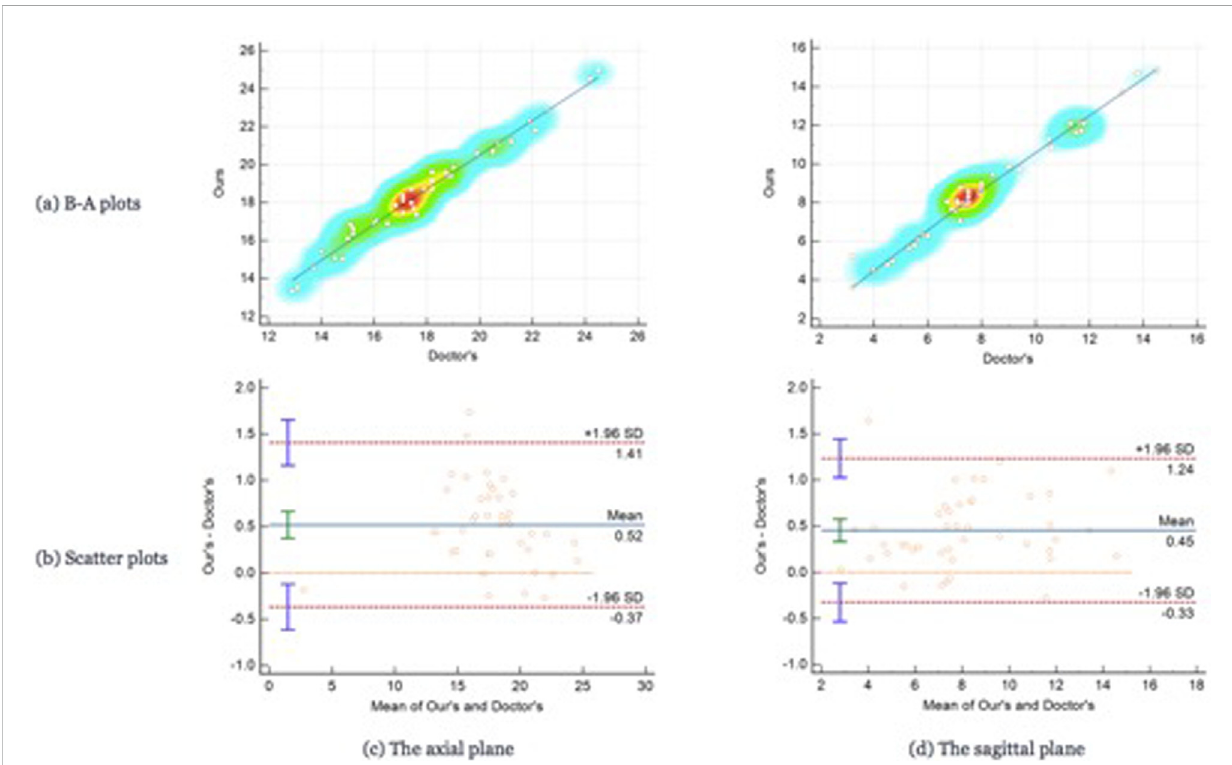
FIGURE 7 The Bland-Altman plots and the scatter plots between the results on the test set using the automated method proposed in this paper. Row (A) represents the Bland-Altman plots and row (B) is the scatter plot, column (C) means the results on the axial plane while column (D) is the results on the sagittalplane.Inthescatterplots,the y -axisrepresentstheresultscalculatedbytheautomatedmethodweproposedinthispaperwhilethe x -axismeans the results measured by the